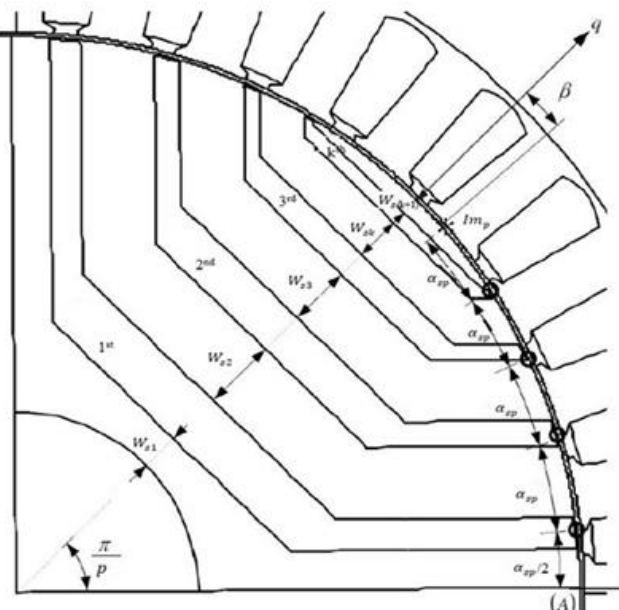
Figure 1. Rotor slot pitch angle, α SP , and its control parameter, β .